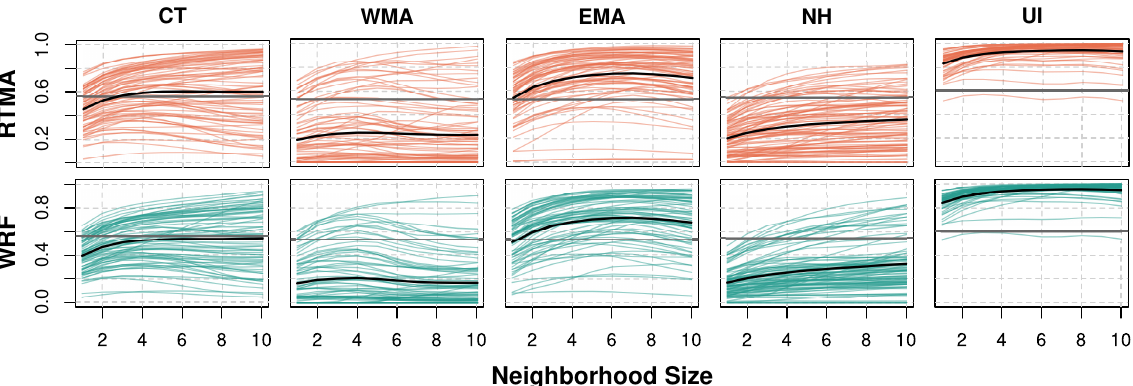
Figure 4. FSS for all events by territory for the RTMA- and WRF-based outage models with a moderate outage risk threshold (0.111 damage locations), plotted for neighborhood sizes 3 × 3 to 21 × 21 grid cells. The colored lines are FSS values for each event; the black line indicates the average FSS over all events; and the horizontal dark grey line indicates the average FSS uniform